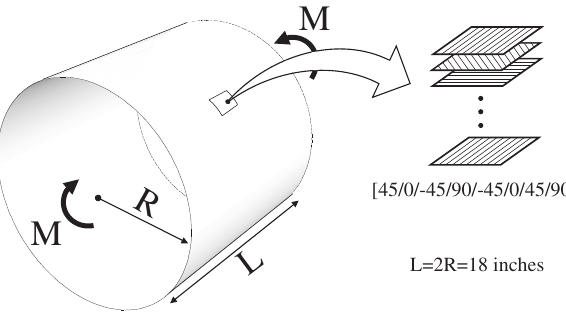
Figure 1: The composite cylinder with QI stacking sequence sub- jected to bending-induced buckling.